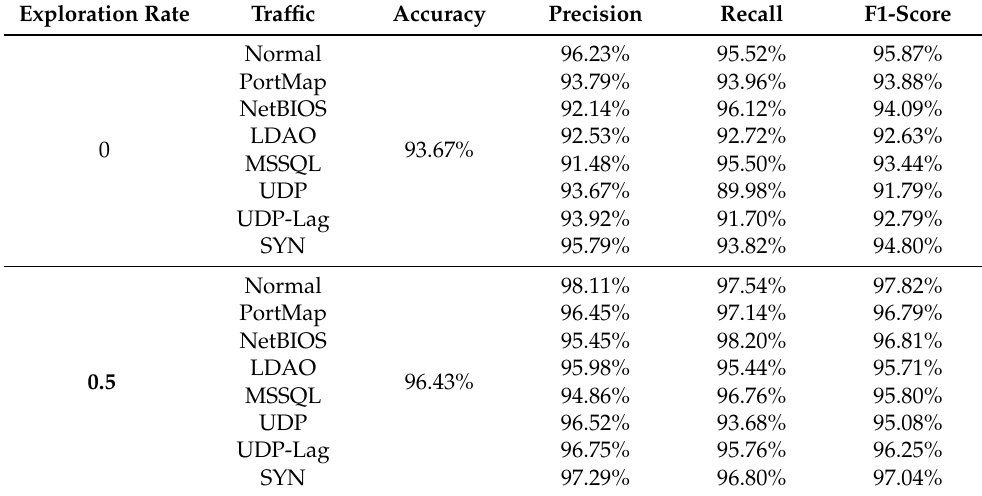
Table 16. Performances on test set with